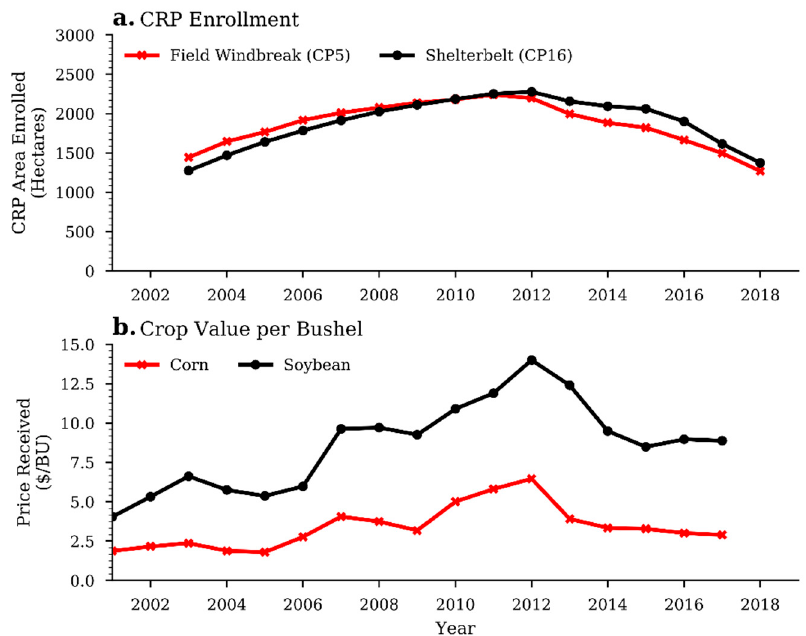
Figure 9. ( a ) The enrolment of shelterbelts in the conservation reserve program (CRP) in North Dakota (USDA FSA), and ( b ) the average annual price per bushel received for corn and soybeans in North Dakota (USDA National Agricultural Statistic Service (NASS)).